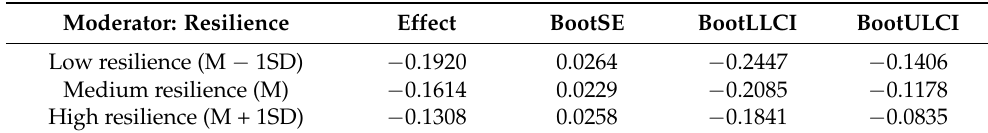
Table 7. Conditional indirect effect at specific levels of the moderator when school belonging was treated as a mediator.